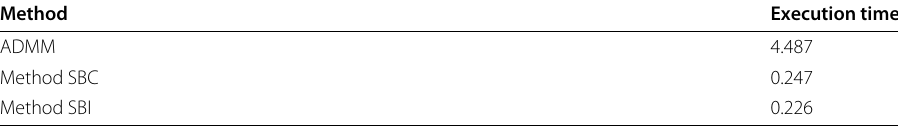
Table 5 Comparison of the second order Methods SBC and SBI with